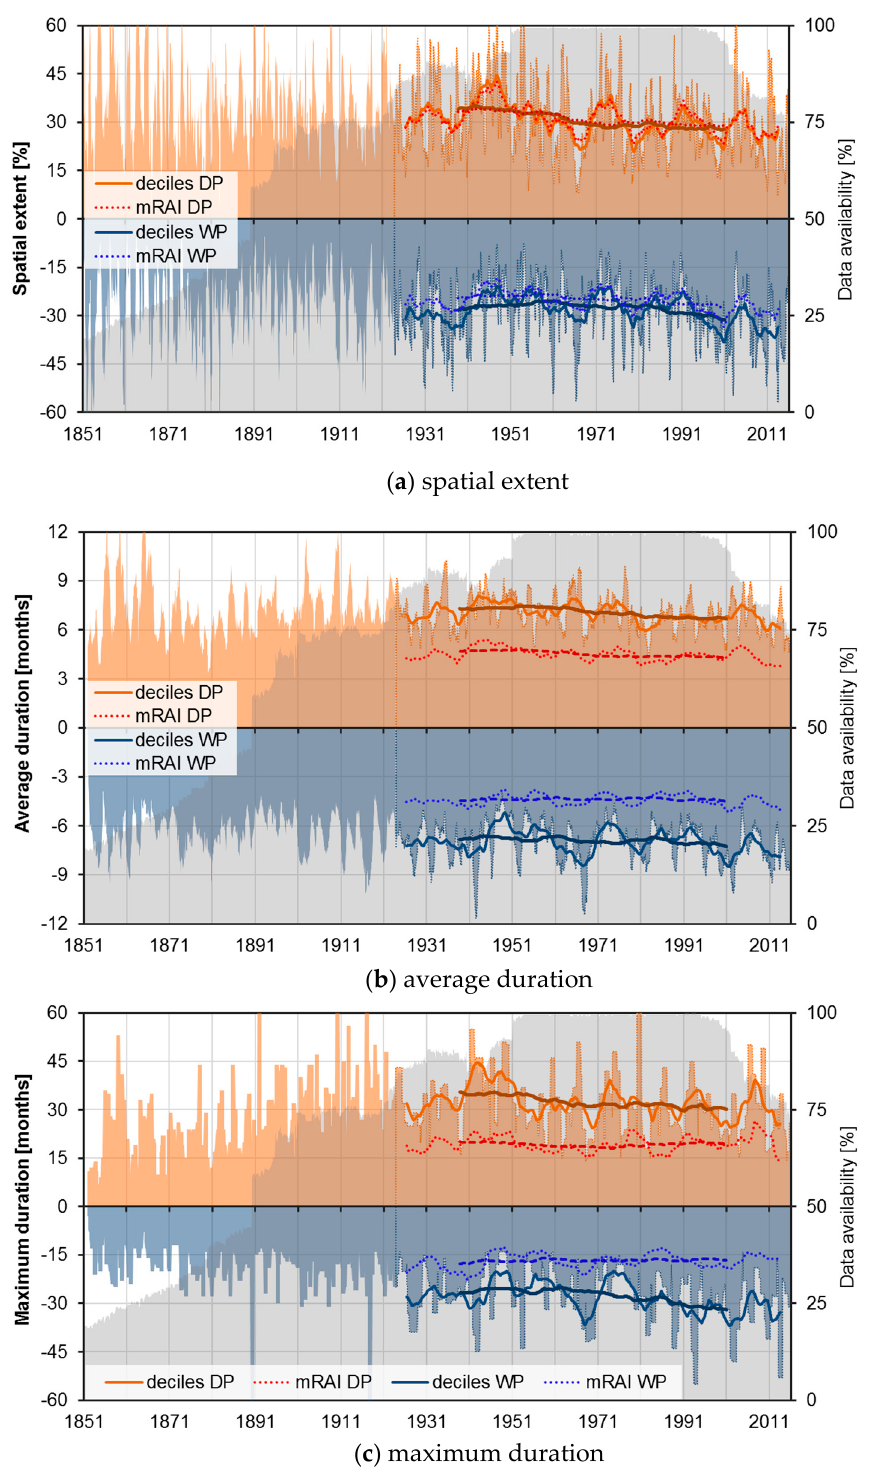
Figure 6. Time series of ( a ) spatial extent, ( b ) average, and ( c ) maximum duration of dry (DP) and wet periods (WP) as indicated by the deciles index and the mRAI for Europe (220 stations) for period 1851–2015. For illustration purposes, the WP results are printed as negative values. The time series in monthly resolution are only printed for the deciles index, while the 5-year and a 30-year low-pass filtered data (from 1924) are printed for both indices.